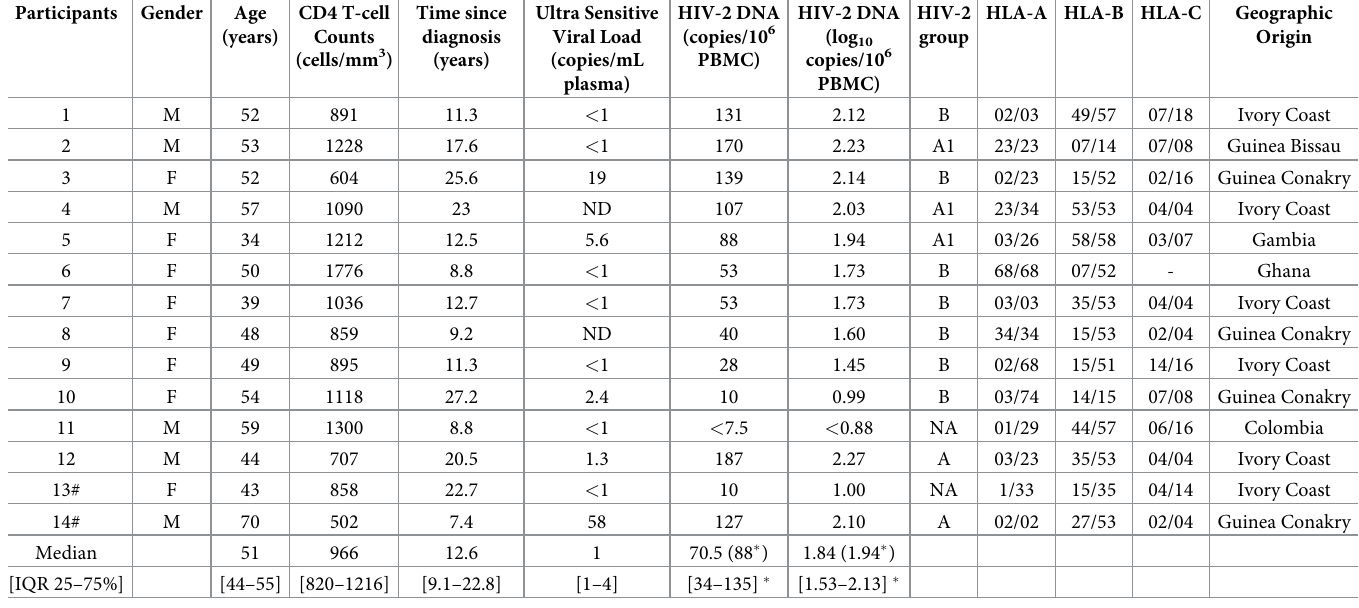
Table 1. Participants